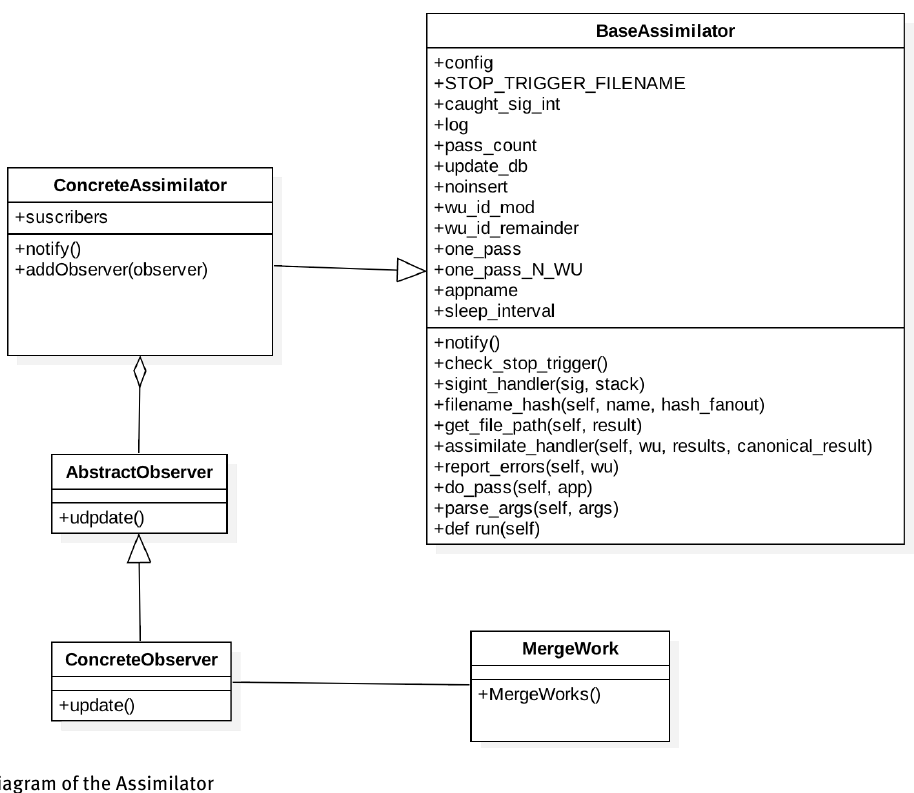
Figure 4: Class Diagram of the Assimilator